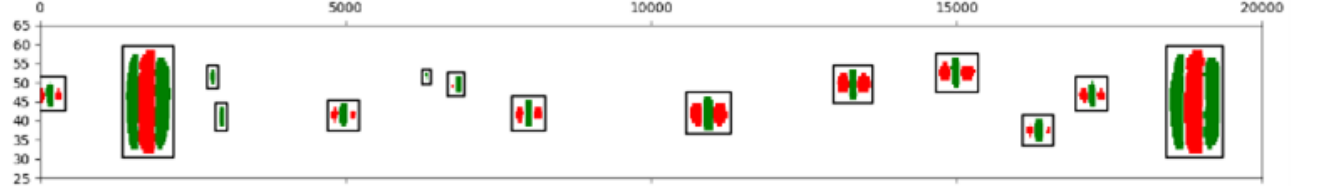
Figure 8. Representative conveyor belt—borders of potentially damaged